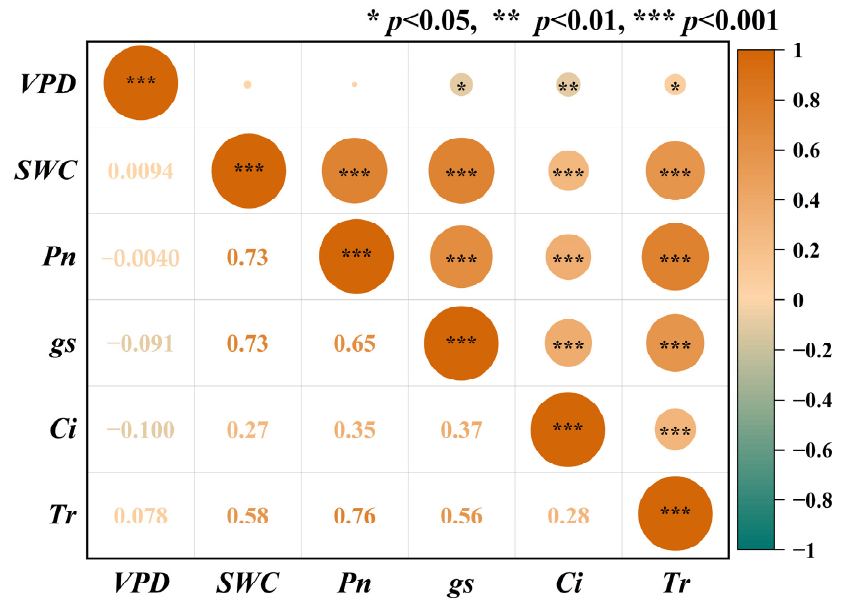
Figure 1. Thermographic analysis of the correlation among photosynthetic parameters, SWC and VPD of C. intermedia plantations in different afforestation years. Note: The numbers represent R 2 correlation values.